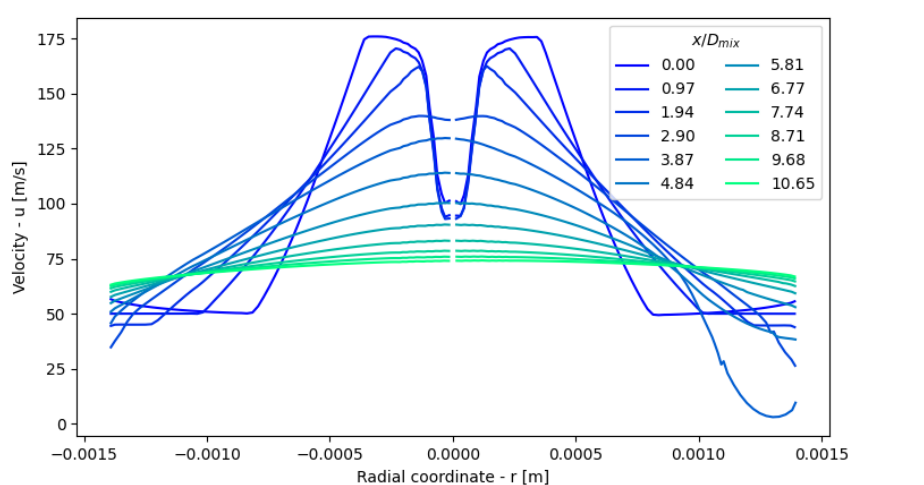
Figure 14. Velocity plot in the z-direction. Positive r direction is in the direction towards the bypass inlet, θ bp = 0 ◦ .